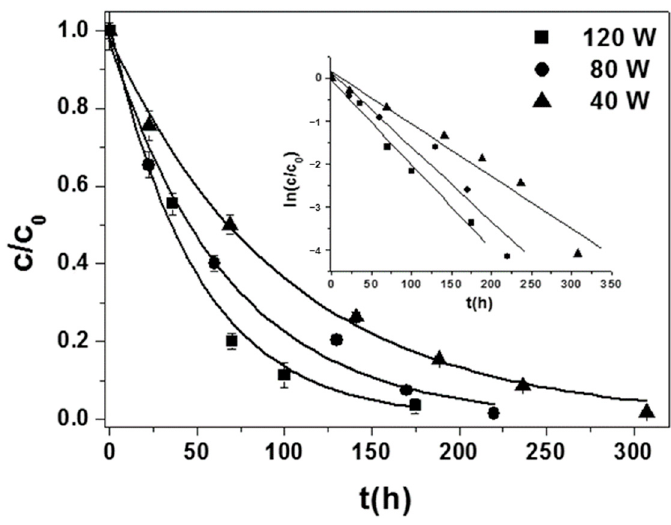
Figure 6. Kinetic trends for the UV/TiO 2 photo-catalysis at different UVB intensity (tests no. 10, 16, 3 ; Q = 0.305 L/s; h 17), MO = 0.7 mg/L; TiO 2 = 0.79 g/cm 3 ; Q = 0.305 L/s; h w = 13.5. In the inset: lnc/c 0 vs. t correlations. 17), MO = 0.7 mg/L; TiO w = 13.5. In the inset: lnc/c 0 vs. t 2 = 0.79 g/cm